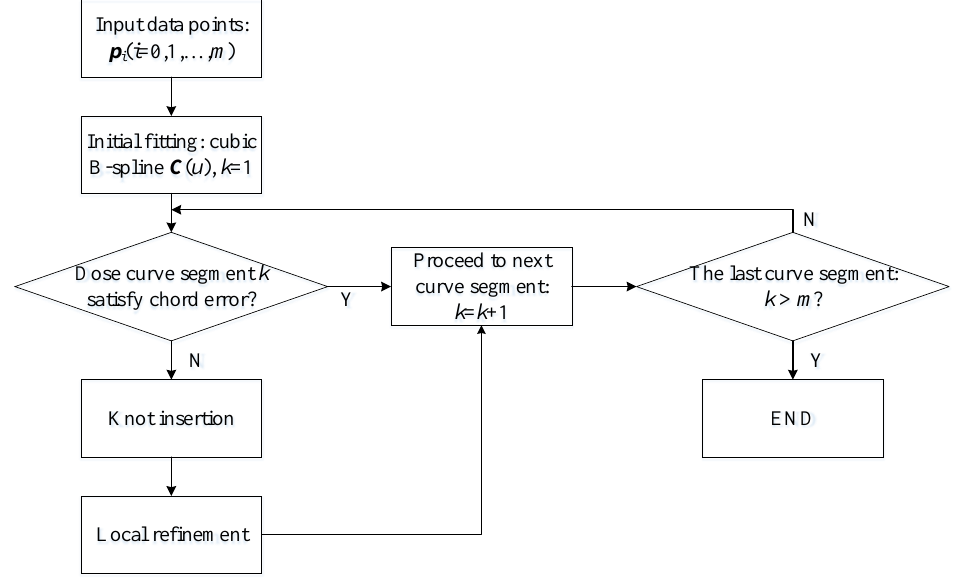
Figure 2. Flowchart of the proposed curve-fitting